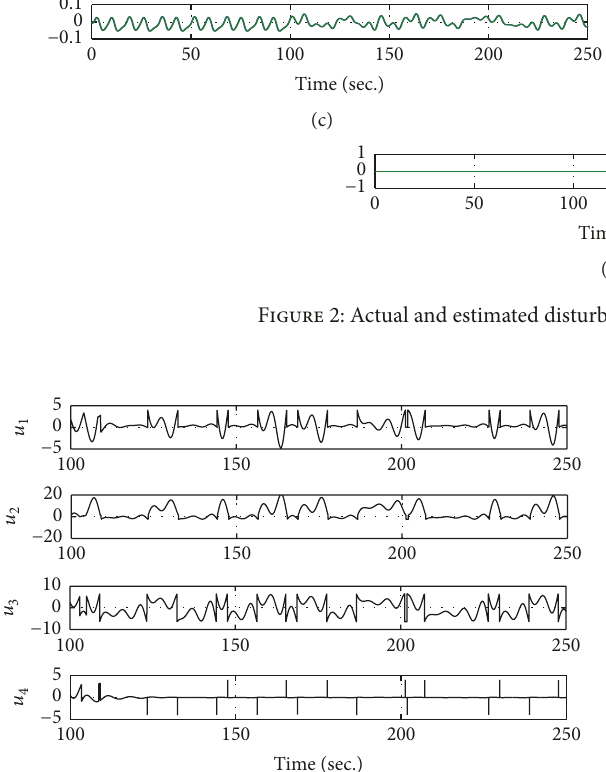
Figure 3: Coupling signals in each node.